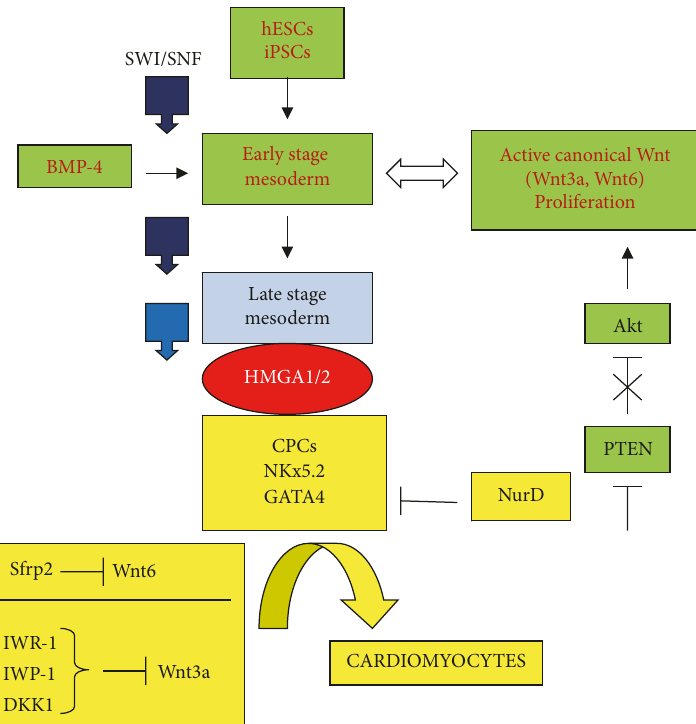
Figure 9: Wnt pathway repression in cardiomyocyte differentiation: from ESCs to cardiomyocytes through cardiac progenitor cells (CPCs). Symbols are the same as shown in Figure